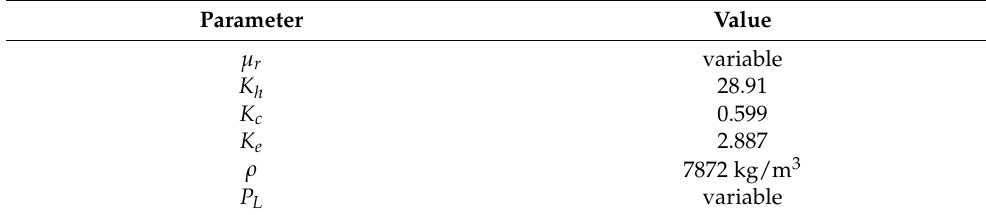
Table 2. Material parameters of the transformer